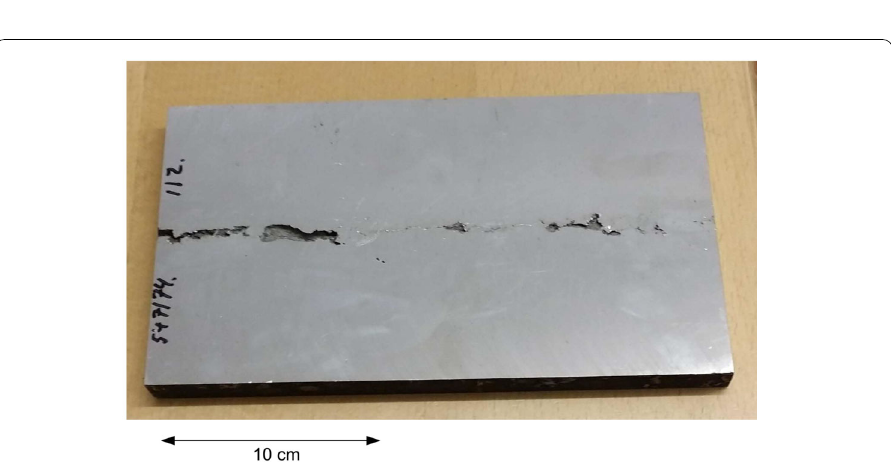
Figure 2 Photograph of a continuous cast steel sample having pores along its centreline. The casting direction was from left to